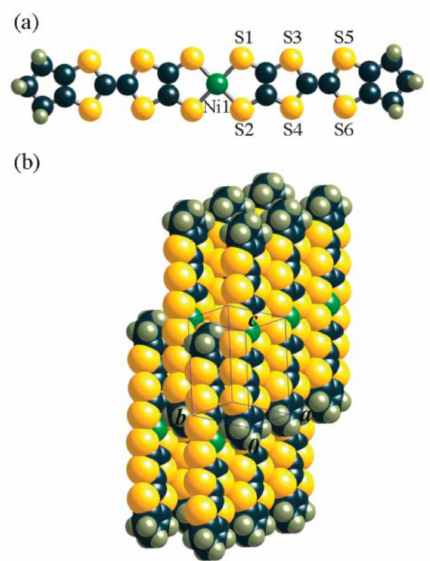
Figure 8. Three-dimensional molecular arrangement in the crystals of Ni(tmdt) 2 : ( a ) molecular structure; ( b ) crystal structure. For tmdt, see Figure 4. The closely packed molecules interact with each other in a three-dimensional way. Reproduced from Ref. [62] with permission from the Royal Society of Chemistry. Copyright